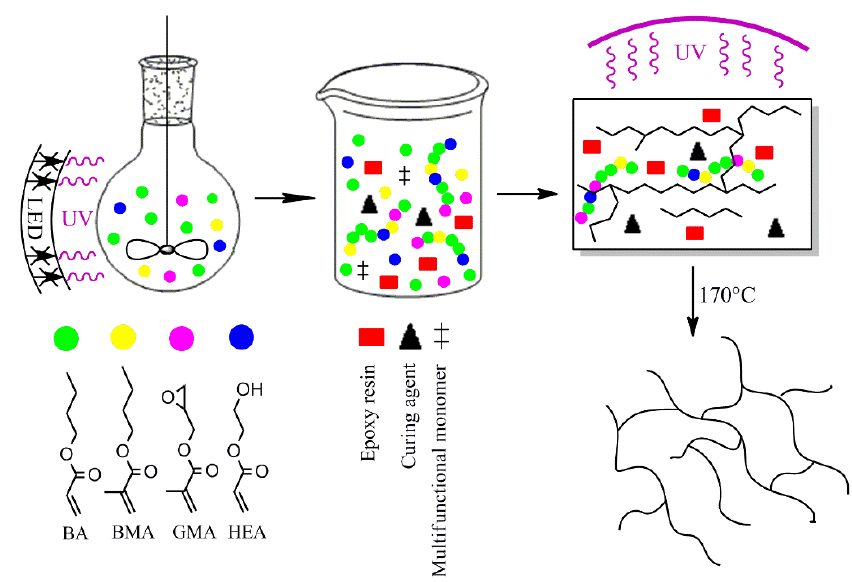
Figure 2. The preparation steps of the self-adhesive structural tapes (SATs).